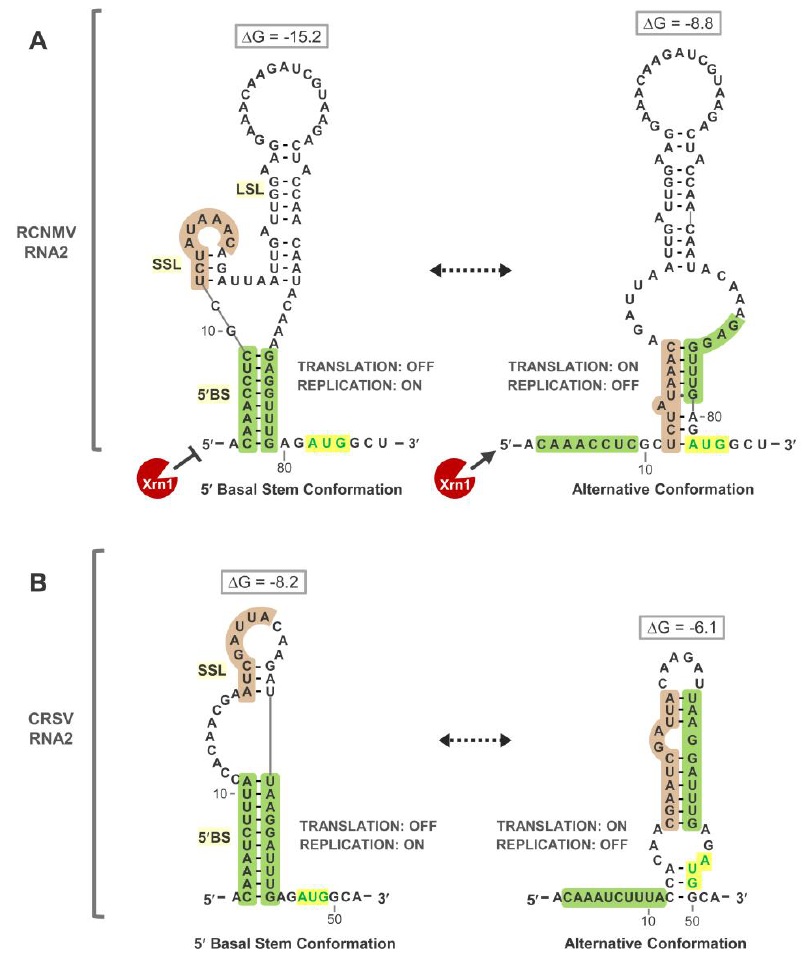
Figure 4. Secondary structural models of candidate 5 (cid:48) UTR conformations in RNA2s of dianthoviruses. ( A ) Candidate 5 (cid:48) UTR conformations for RCNMV RNA2. To the left, the SHAPE-predicted 5 (cid:48) BS